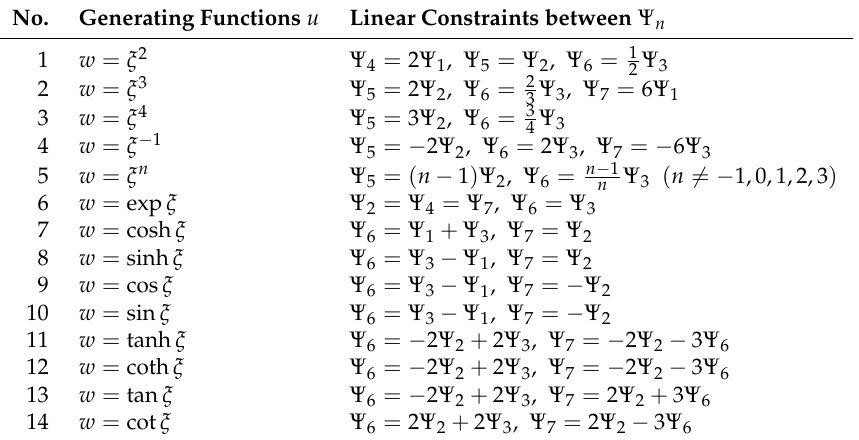
Table 1. Generating functions w and corresponding linear relations among Ψ n